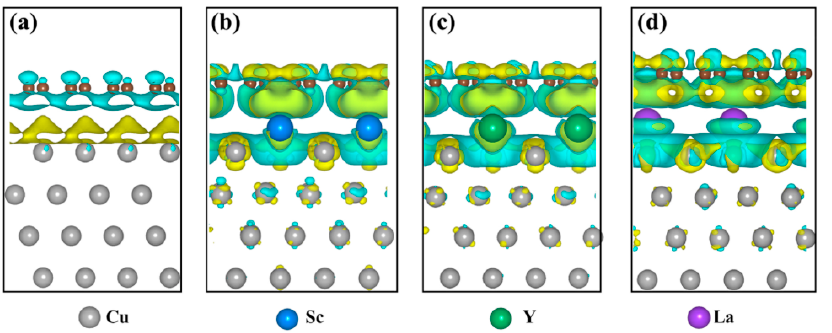
Figure 14. Differential charge density of different interfaces calculated by GGA + vdw: ( a ) clean interface; ( b ) Sc doped interface; ( c ) Y doped interface; ( d ) La doped interface [41]. Reprinted/adapted with permission from Ref. [41]. Copyright year 2022, Elsevier.